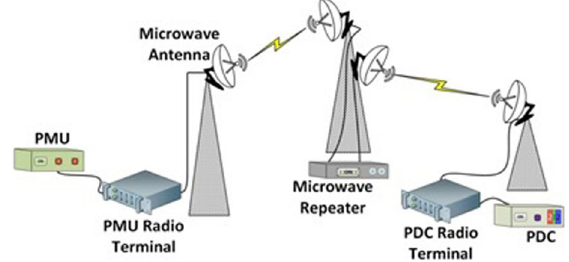
Fig. 11 Microwave Based Synchrophasor Communication System